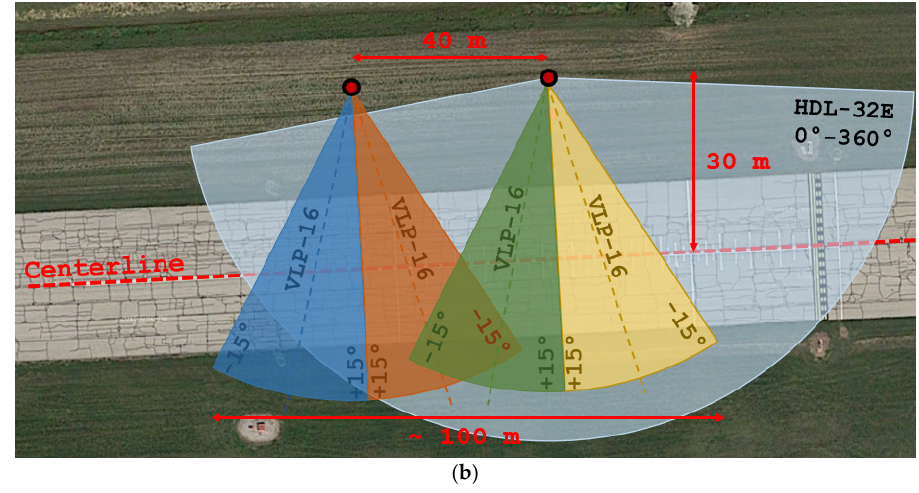
Figure 9. Test sensor configurations: ( a ) Test #1 sensor network (taxiing), and ( b ) Test #2 sensor network configuration (landing). Table 2. Overview of the field tests (* projected to the runway centerline).